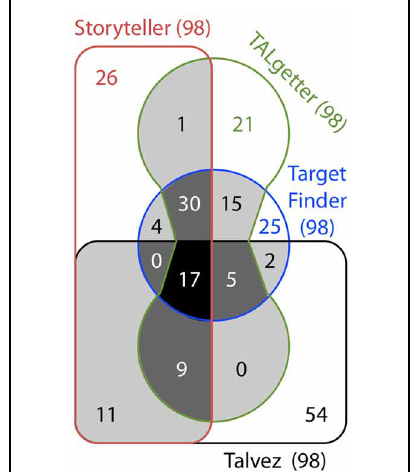
FIGURE 1 | Venn diagram representing the shared targets of Hax4 (GenBank AY993939; RVDs = NI HD HD NG NS NS NI HD NG NI NS NI NG NI NG) predicted in the Arabidopsis promoterome (1kb upstream of the translation start site from the Col-0 ecotype genes in the TAIR annotation release 10) with the 4 currently available algorithms for TAL target prediction: Storyteller (parameters: rounds “10 5 ”, noise “0.5”, noise-shape “hvaa-dependent,” max e-value “700,” minscore “2,” gap probability “10 − 3 ”), TALgetter (default parameters: “TALgetter long”), Talvez (version 3.1, parameters: pseudocounts “10 − 5 ”, minimum score “9”, number of reported TALEs “100” and position correction “19”) and Target Finder (TALE-NT 2.0, default parameters). Shaded areas in light gray, dark gray and black indicate putative targets identified with 2, 3 or 4 prediction algorithms, respectively. Numbers in bracket indicate the total number of predicted targets for each prediction